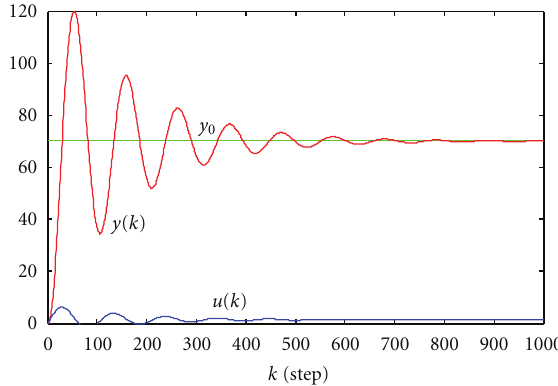
Figure 2: Control result of system